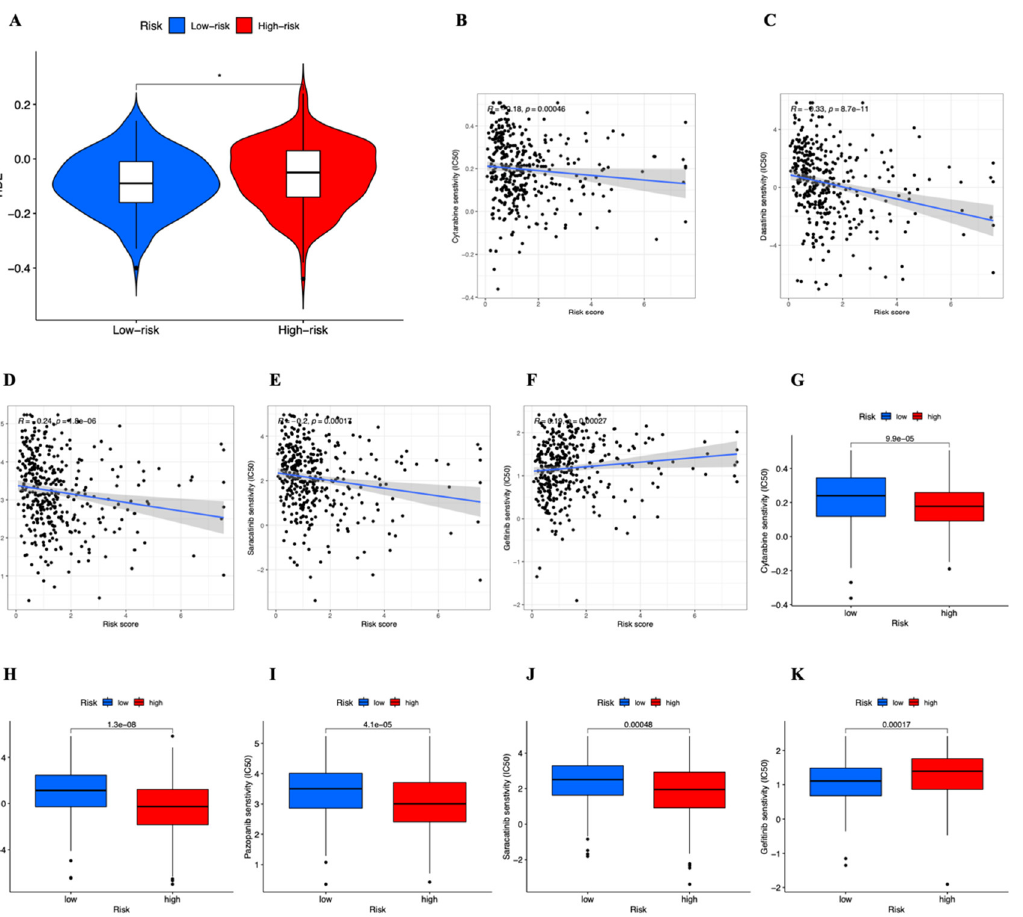
Figure 10. ( A ) TIDE scores between the high- and low-risk groups. ( B – K ) The role of risk score model in STAD treatment. The correlation between the risk score and estimated IC50 value of ( B ) Cytarabine, ( C ) Dasatinib, ( D ) Pazopanib, ( E ) Saracatinib and ( F ) Gefitinib. Comparison of estimated IC50 value of ( G ) Cytarabine, ( H ) Dasatinib, ( I ) Pazopanib, ( J ) Saracatinib and ( K ) Gefitinib between high- and low-risk groups.